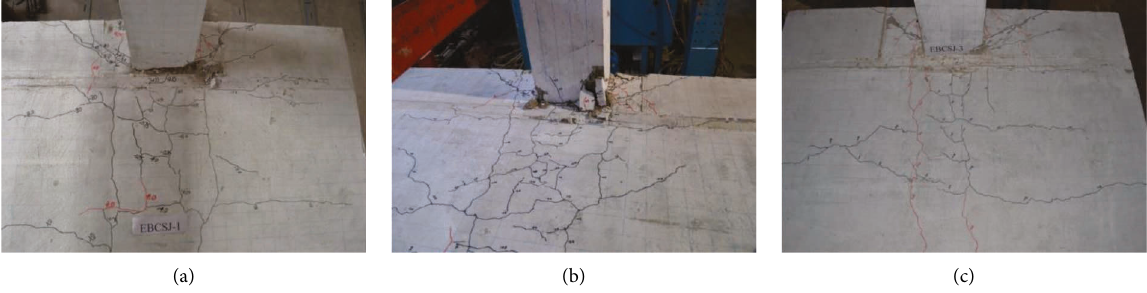
Figure 8: Crack patterns in the beam-column intersection zone and slab. (a) EBCSJ1. (b) EBCSJ2. (c)